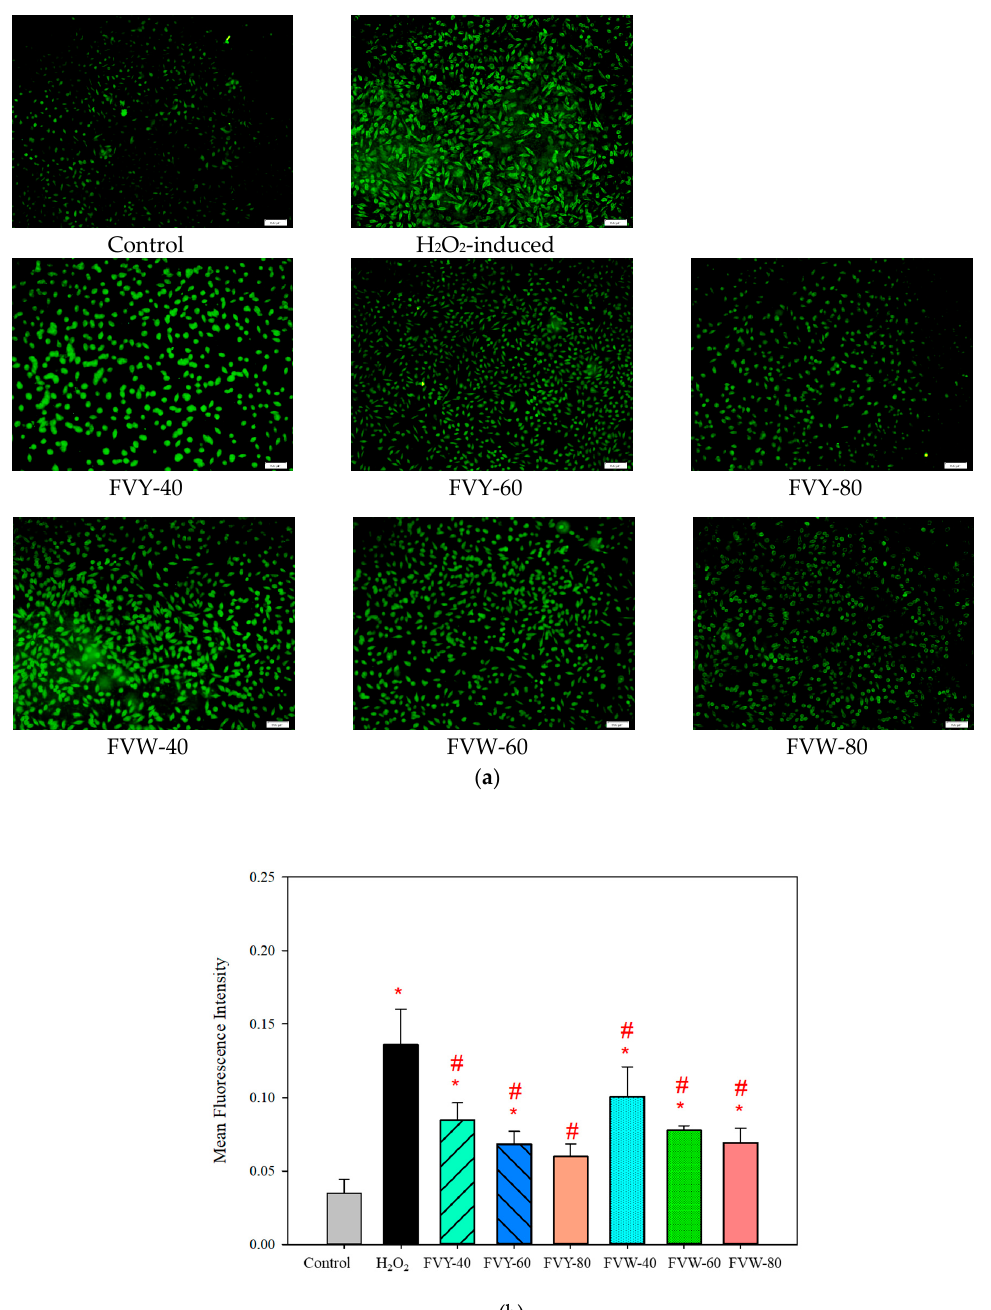
Figure 7. Cell viability was analyzed by 3-(4,5-dimethylthiazolyl-2)2,5 diphenyltetrazolium bromide (MTT) assay. L929 were treated with ( a ) FVYs and ( b ) FVWs for 24 h. Data were expressed as a mean ± standard deviations . ( n = 4). ( p < 0.05).